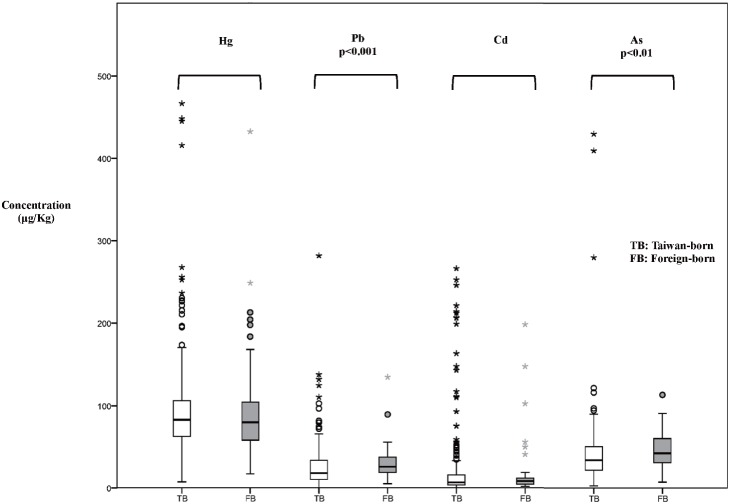
Box and whisker plots display distributions of Hg, Pb, Cd, and As concentrations in meconium (µg/kg) among babies of Taiwan-born and foreign-born mothers.Median (horizontal line in the box), minimum, and maximum are shown. The box includes 50% of values and is limited by the 25th and 75th percentiles.